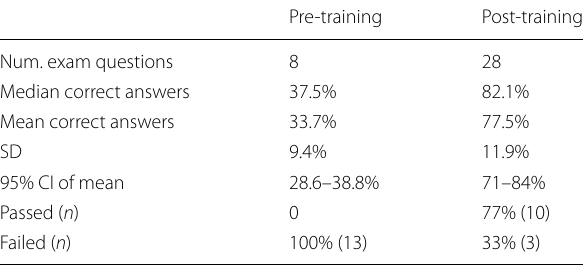
Table 3 Summary of written exam scores for 13 trainees pre-